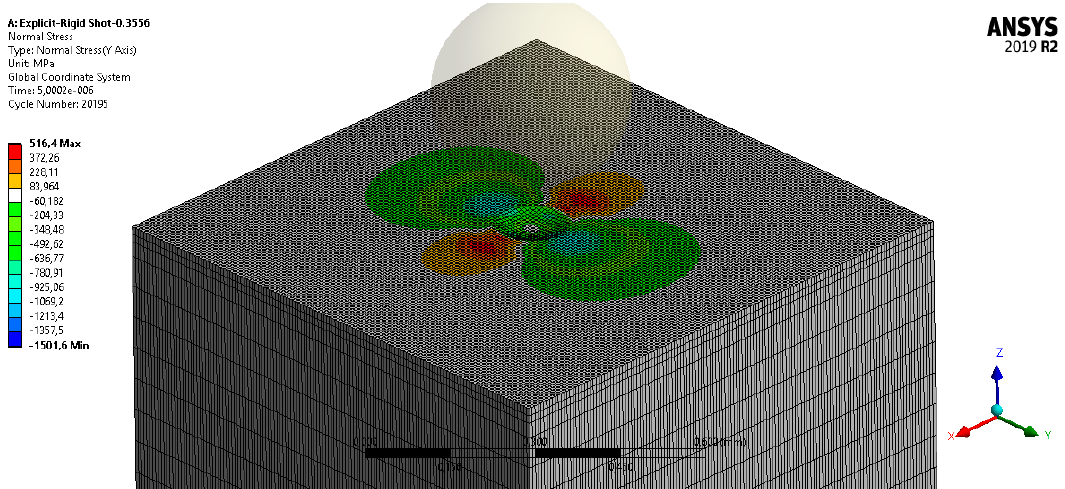
Figure 4. Single-shot simulation model in 3D mesh, showing residual stress map on workpiece surface after rebound.